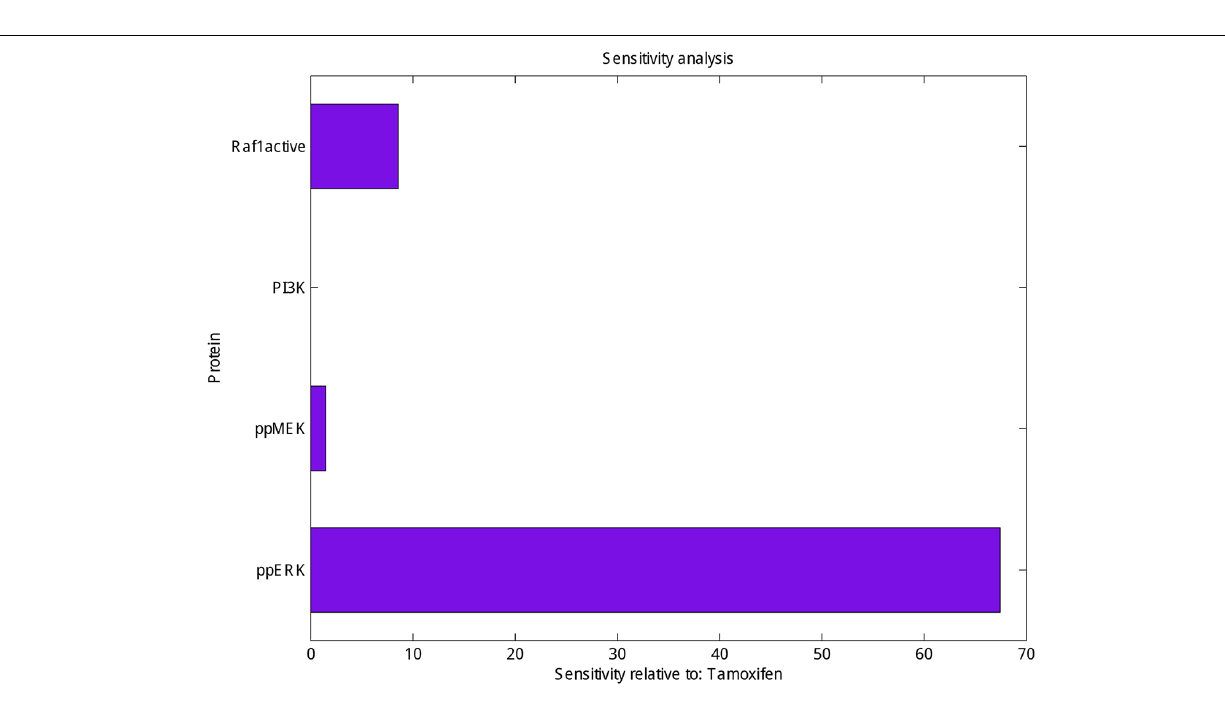
Frontiers in Physiology |